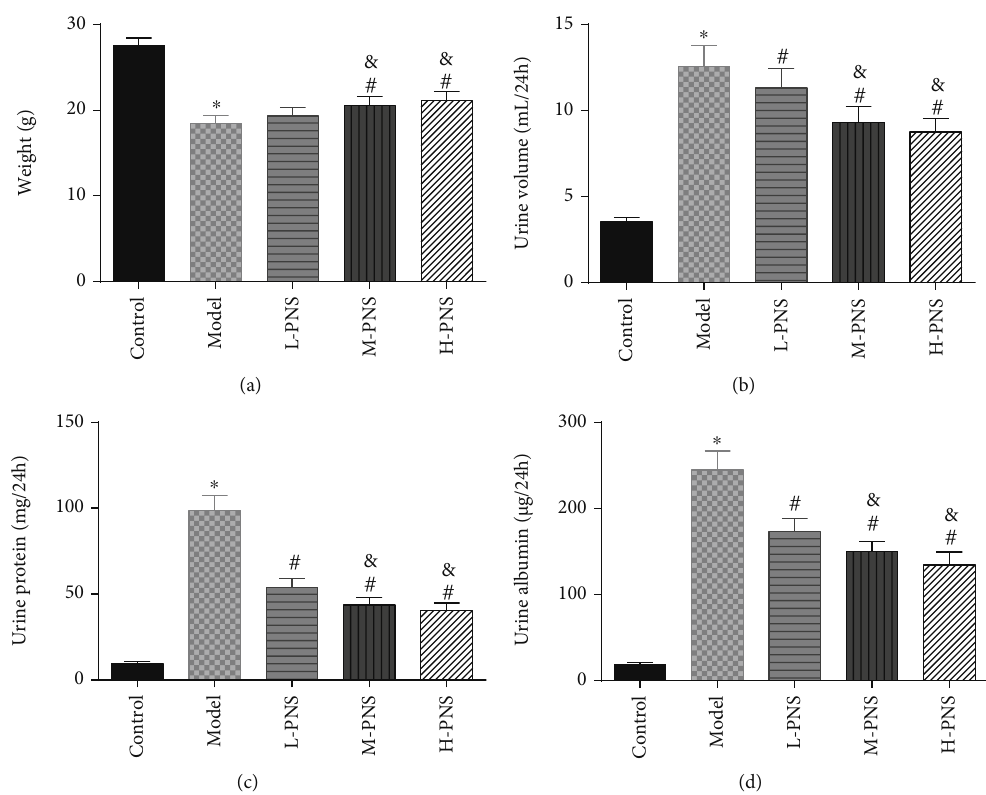
Figure 1: Symptoms of diabetic mice ((a) weight change of mice. (b) 24 h urine volume of mice. (c) 24 h urine protein content of mice. (d) 24h urine albumin of mice; ∗ P < 0 : 05 vs. control; # P < 0 : 05 vs. model; & P < 0 : 05 vs.